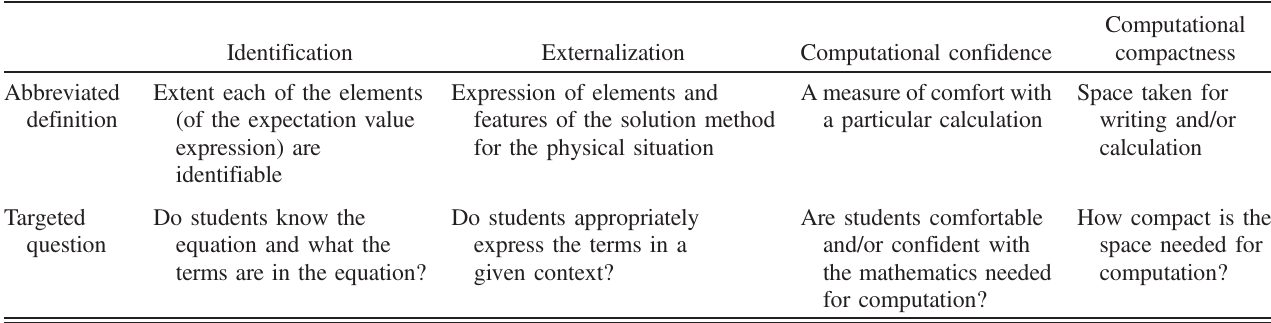
TABLE I. Definitions and targeted questions of the computational features used to analyze students ’ calculation of expectation